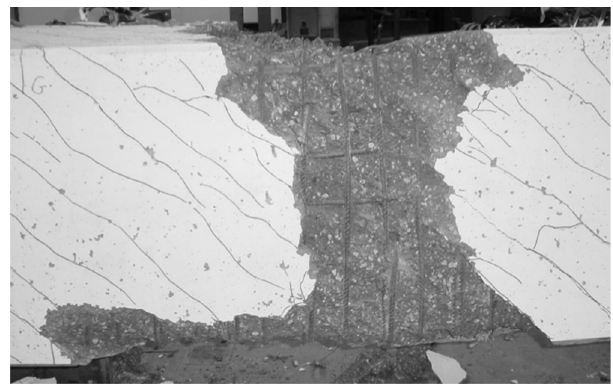
Figure 11. Fragile failure by crushing of concrete: Beam D-3.08. Table 4. Cracking parameters.